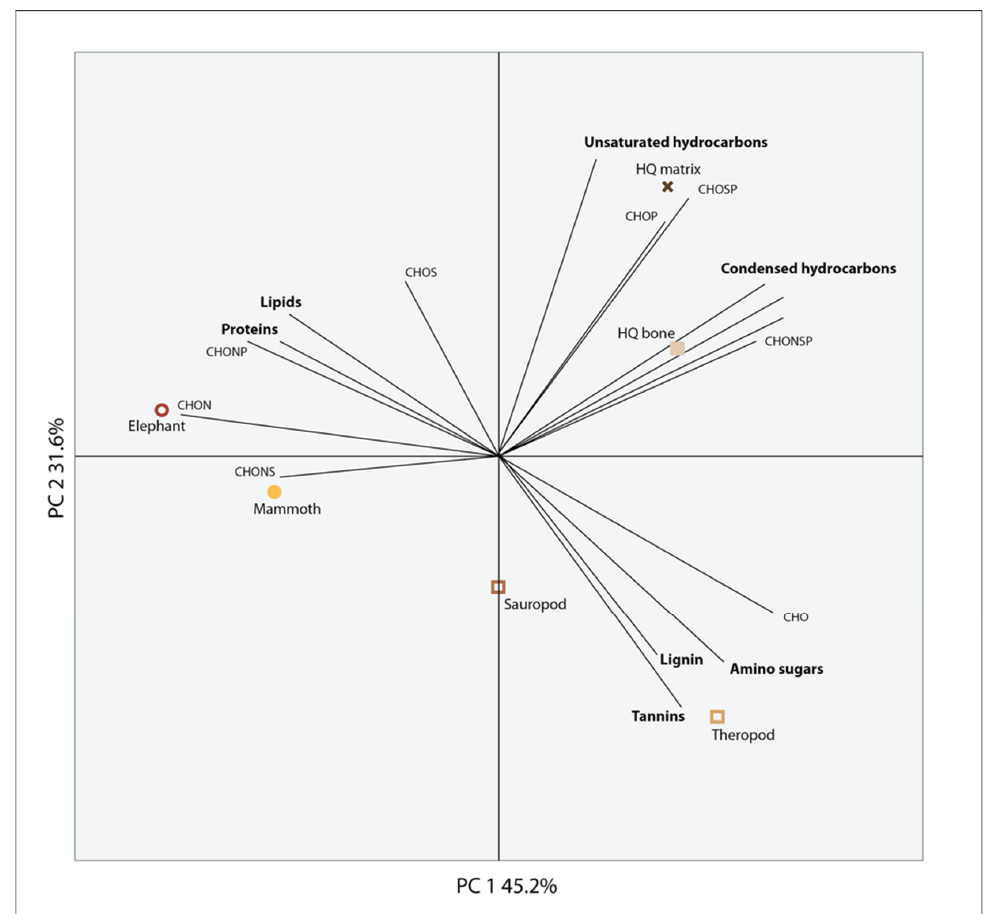
Figure 4. Principal component analysis of FT-ICR MS data. Examination of fossil bones by grinding them up and not demineralizing them reveals additional compounds in greater abundance than proteins and lipids. Proteins and lipids are in the greatest abundance in the elephant and mammoth bones, whereas the Morrison and Hell Creek bones have higher abundances of lignin, tannins and amino sugars and the HQ bones have a higher abundance of unsaturated and condensed hydrocarbons. Amino acids were found in the dinosaur bones and matrix but may be masked by the environmental compounds that are more abundant. Tannins could be any oxygenated compound and lignin could be phenols of plant or microbial origin.